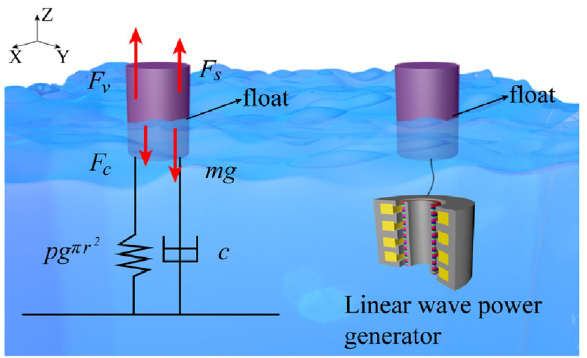
Fig. 1 The motion of a float in a